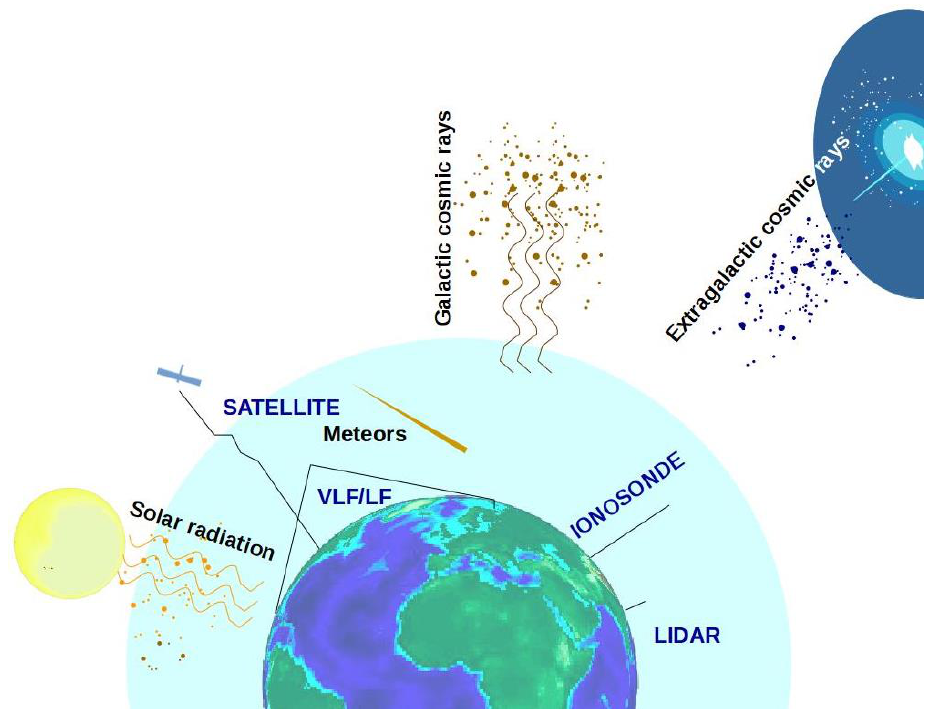
Figure 1. Scheme of outer space’s influence on the Earth’s atmosphere. Extraterrestrial electromag- netic and particle radiation coming from the Sun, our galaxy, and the wider universe, and impact of meteors in the Earth’s atmosphere. Several examples of the remote sensing of the atmosphere: troposphere observations by LIDAR, VLF/LF signal monitoring of the lower ionosphere, ionospheric monitoring using signals emitted by ionosondes, satellite